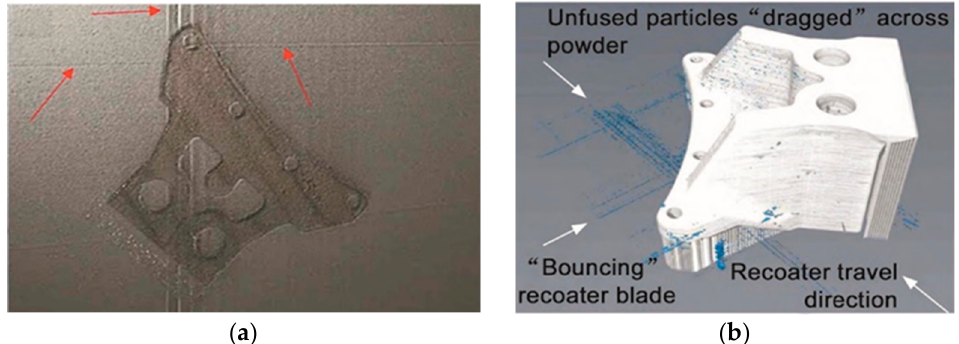
Figure 14. Melt layer inspection based on visual imaging. ( a ) Melt layer image; ( b ) 3D reconstruction model and powder bed anomaly [6].